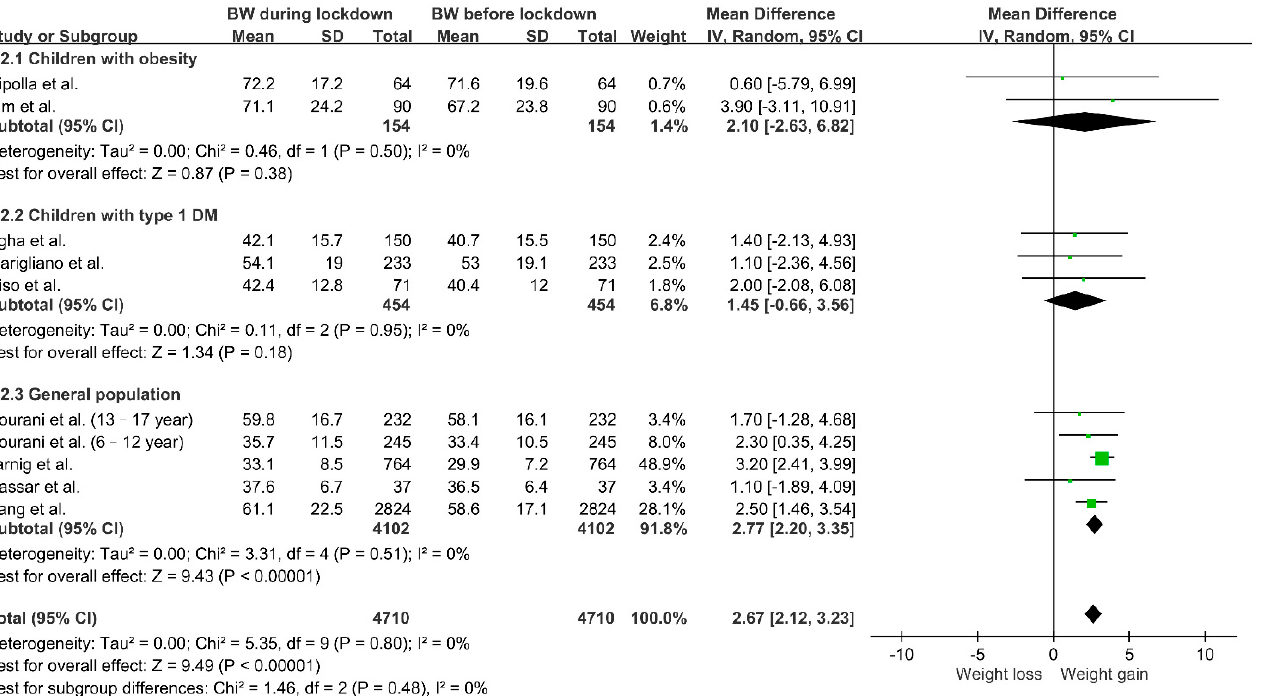
Figure 2. Changes in body weight during lockdown in children. Study populations were further divided into three groups (children with obesity, children with type 1 diabetes mellitus and children without comorbidities), and subgroup analysis was performed. Abbreviations: BW, body weight; DM, diabetes mellitus.